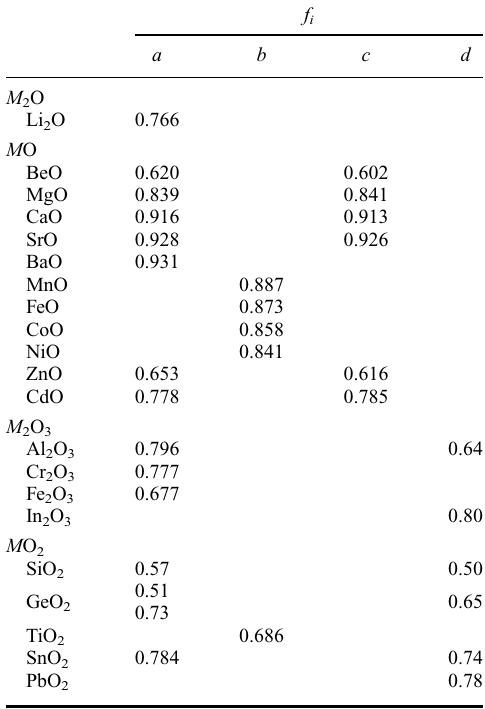
TABLE III f i Values Predicted by the Dielectric Theory for 21 Binary